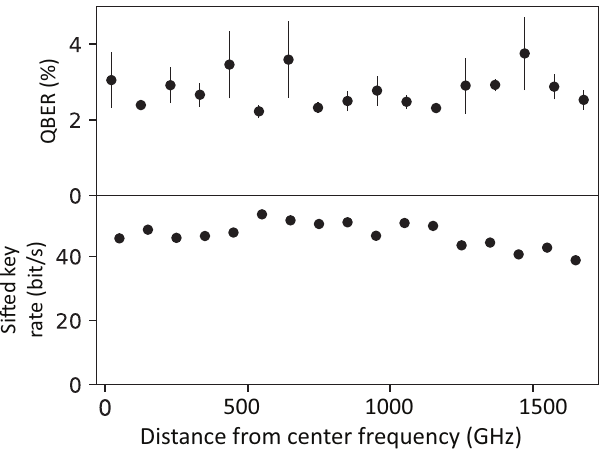
FIG. 6. The QBER and sifted key rate for key exchange between Charlie and Bob over 60.5 km of fiber for different AWG channel pairs symmetric around our center frequency. Each data point is averaged over eight consecutive 90-s runs. The error bars represent the standard deviation of the QBER for each channel. The error bars of the sifted key rate are so small that they are not